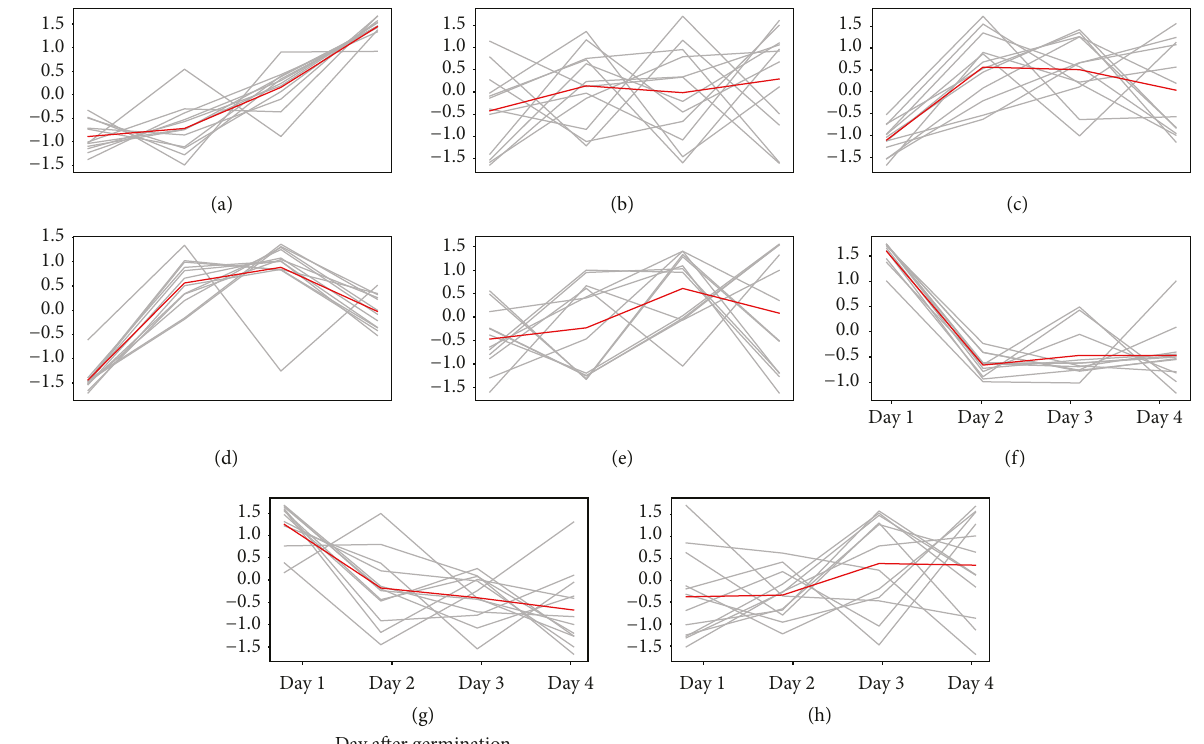
Figure 5: Changes of metabolites in mung bean sprouts for 4 days. (a) Neochlorogenic acid, (b) chlorogenic acid, (c) catechin, (d) caffeic acid, (e) syringic acid, (f) isovitexin, (g) vitexin, and (h) p-coumaric acid. The cluster analysis was performed by the K-means method. The red lines are representative of trends in each